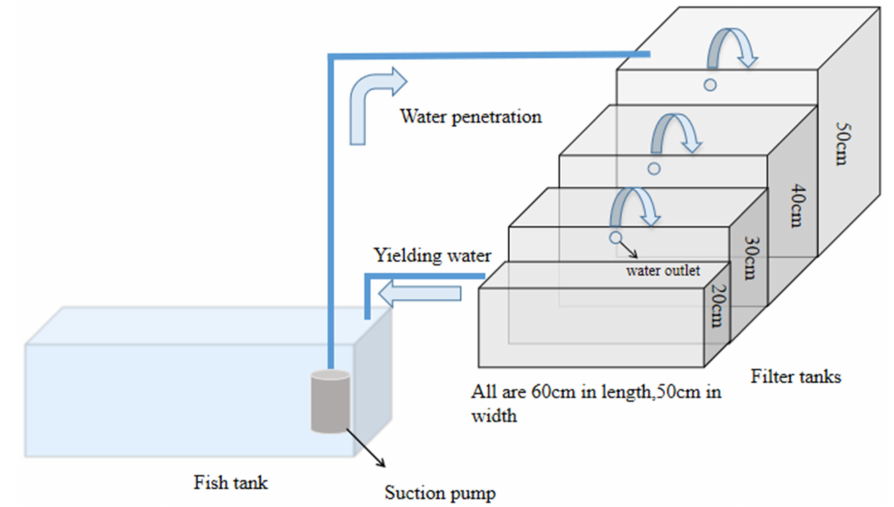
Figure 1. Diagram of the tested aquaponics